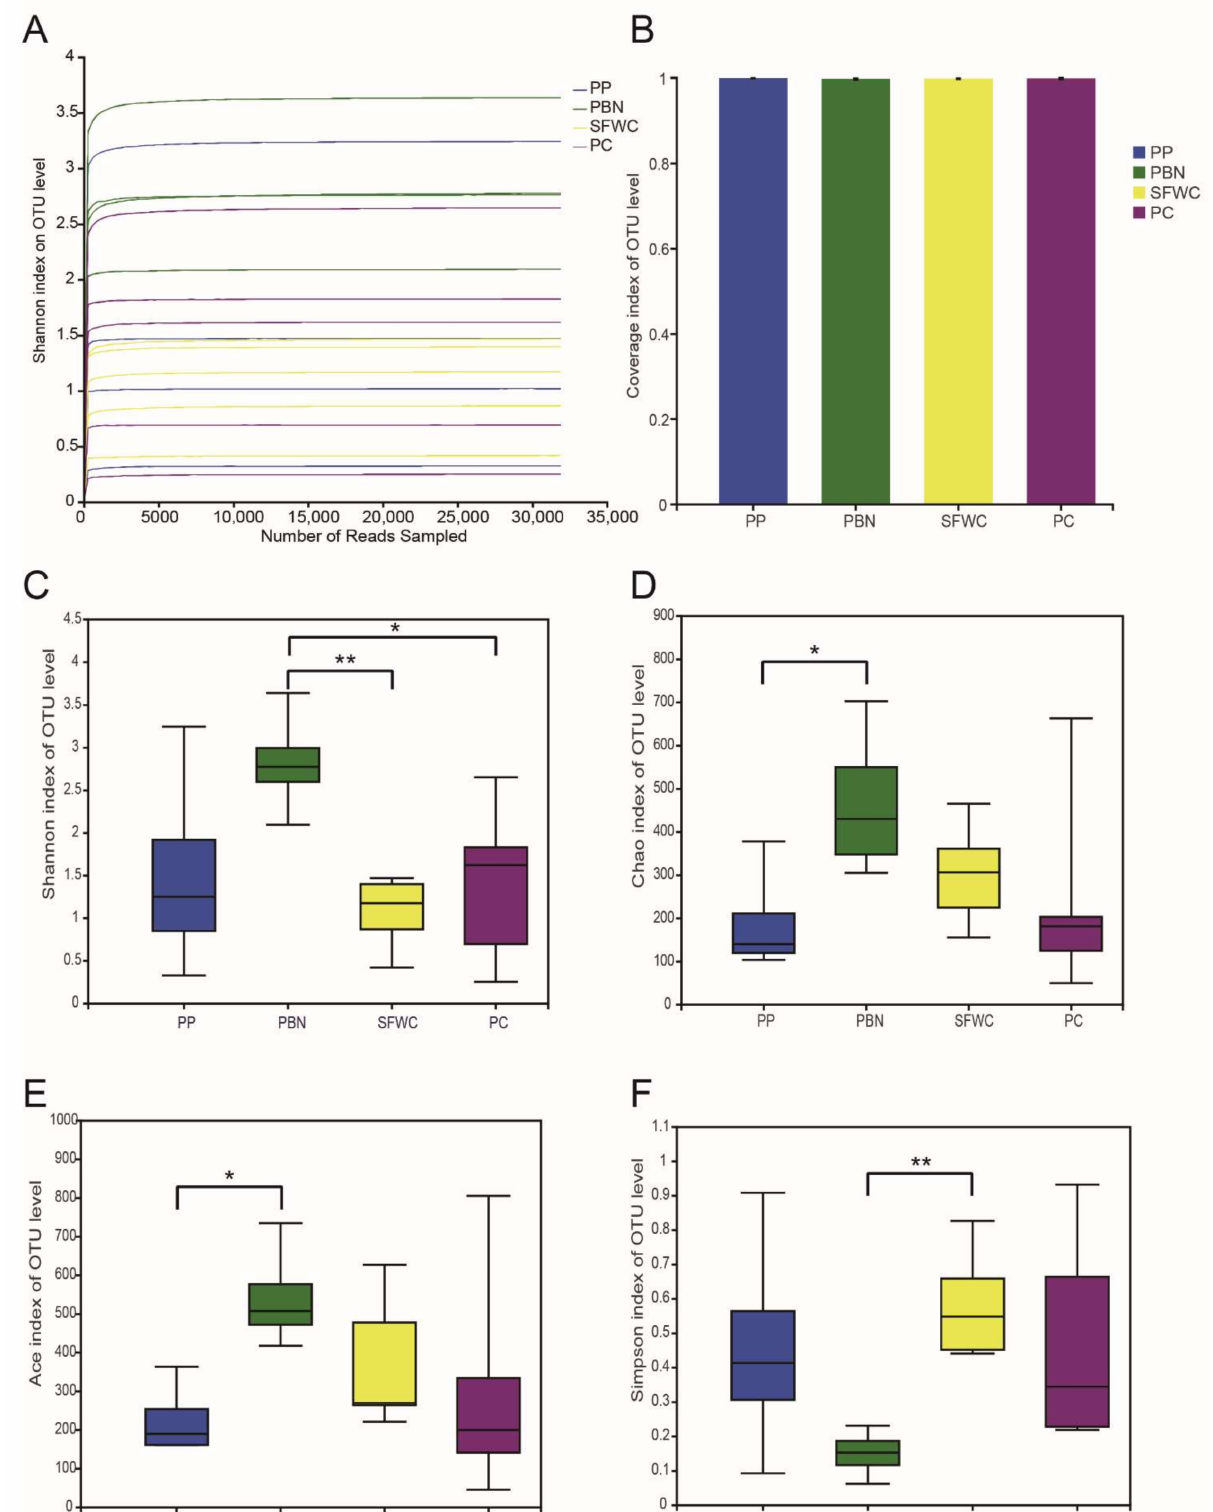
Figure 2. Alpha-diversity of bacterial community of four traditional fermented vegetables. ( A ) Shan- non curve for each sample. ( B ) Coverage index. ( C ) Shannon index. ( D ) Chao value. ( E ) Ace index. ( F ) Simpson index. * p < 0.05, ** p <